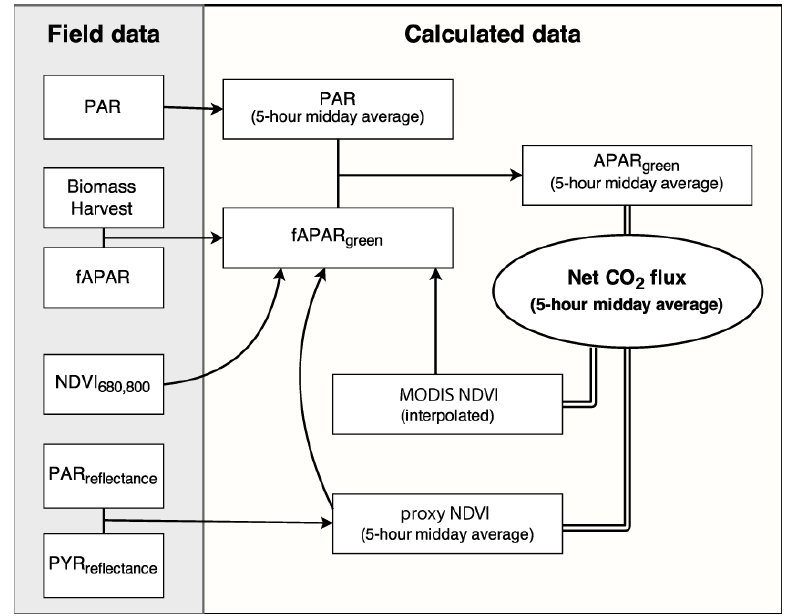
Figure 3. Experimental design, summarizing steps used in derivation of NDVI and APAR green (arrows), for comparisons with net CO 2 fluxes (double lines). As indicated, APAR green was estimated from the different NDVI metrics by regression of measured f APAR green against proxy NDVI, and multiplying f APAR green with PAR (photosynthetic photon flux density, measured with PAR sensors). Because the proxy NDVI provided continuous measurements, it was used to derive APAR green for comparison against Net CO 2 flux. Further explanation can be found in the text.